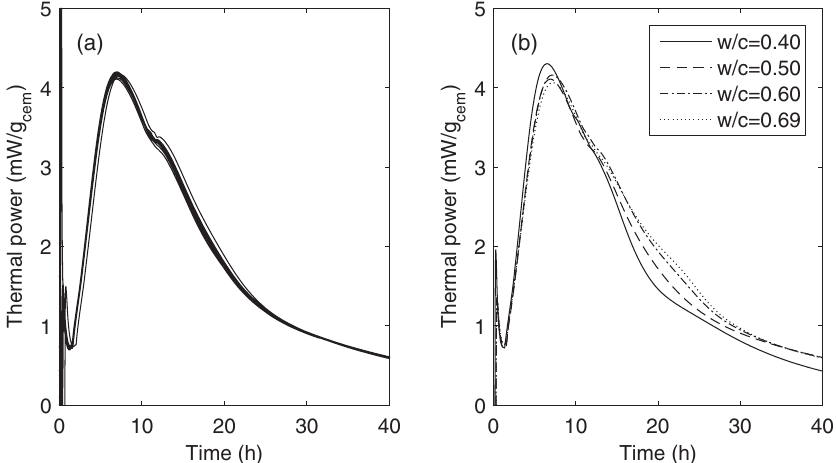
FIG. 2. Results of isothermal calorimetry on cement paste (no aggregate) discussed in the text. (a) Twelve repeats of hydration measurements made over a 140 day period. (b) Results for different water/cement